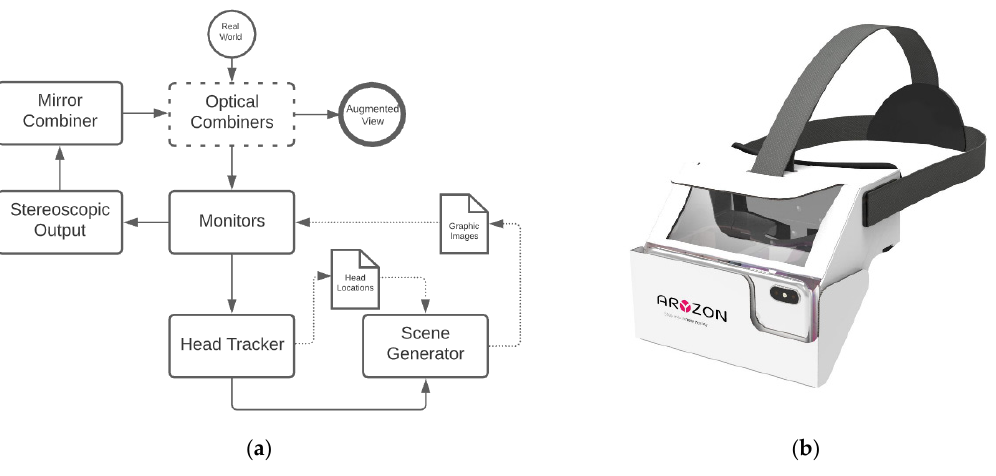
Figure 3. ( a ) Mirror-based AR, ( b ) Aryzon Headset. Advancing the AR hardware framework further, approaches include coupling the headset with hand-held controllers, for instance with embedded QR code markers on the controller shaft. This provides real-time detection of the users’ hand movements. In this instance, the AR hardware framework can be extended to include motion input, as in Figure 4. Humans naturally prefer a multimodal approach for a higher level of interaction [33], rather than being passive observers. The integration of controllers into the mix provides natural extension of the AR interaction processes for a greater level of